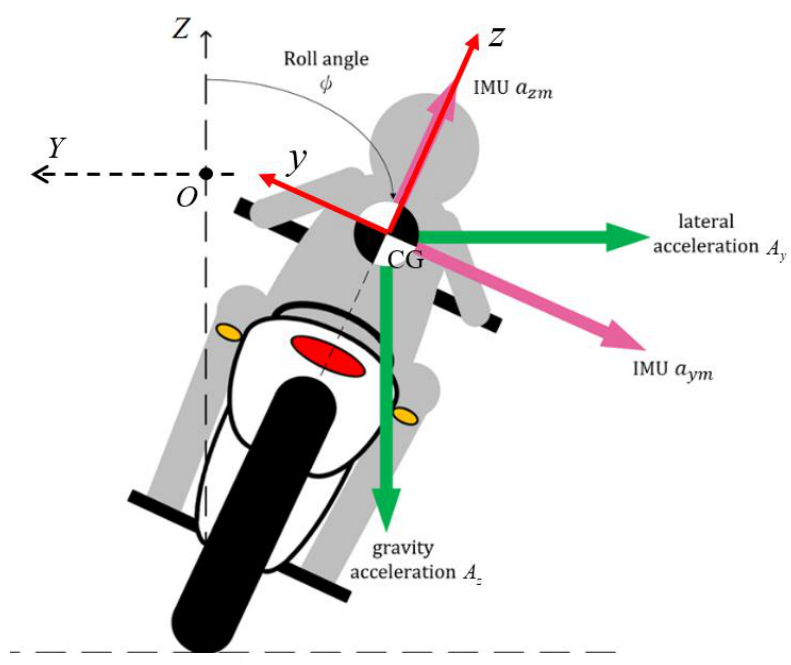
Figure 2. Dynamics of a turning motorcycle.